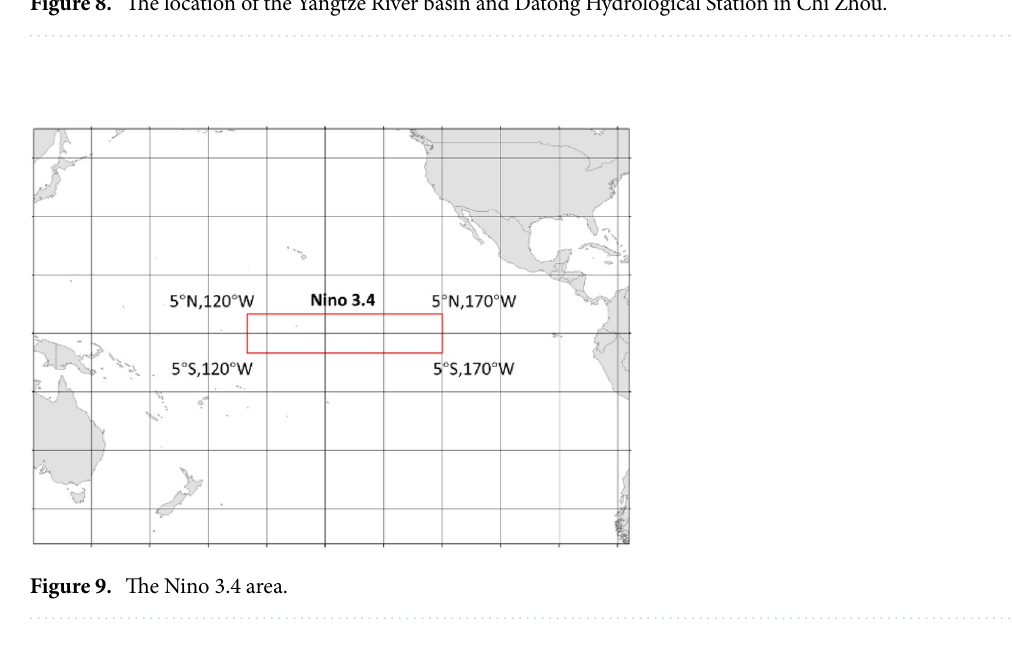
Figure 8. The location of the Yangtze River basin and Datong Hydrological Station in Chi Zhou.